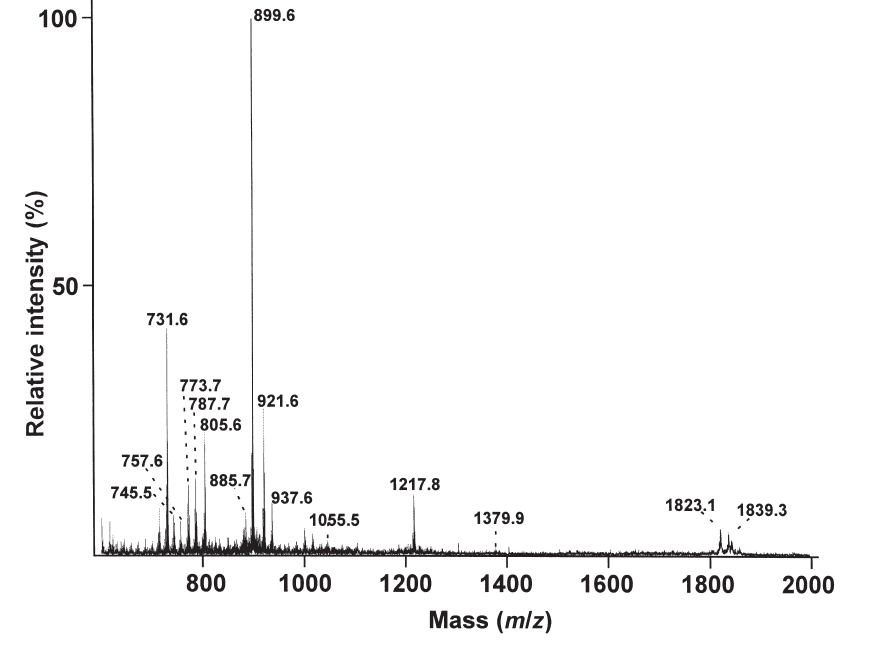
sulfate-diglycosyl-A S , m / z = 1055.5; sulfate-triglycosyl-A S , m / z = 1217.8; and sulfate-tetraglycosyl-A S , m / z = 1379.9. Signals at m / z = 1823.1 and 1839.3 are interpreted as Na + and K + forms of dimers formed from fragment ions during